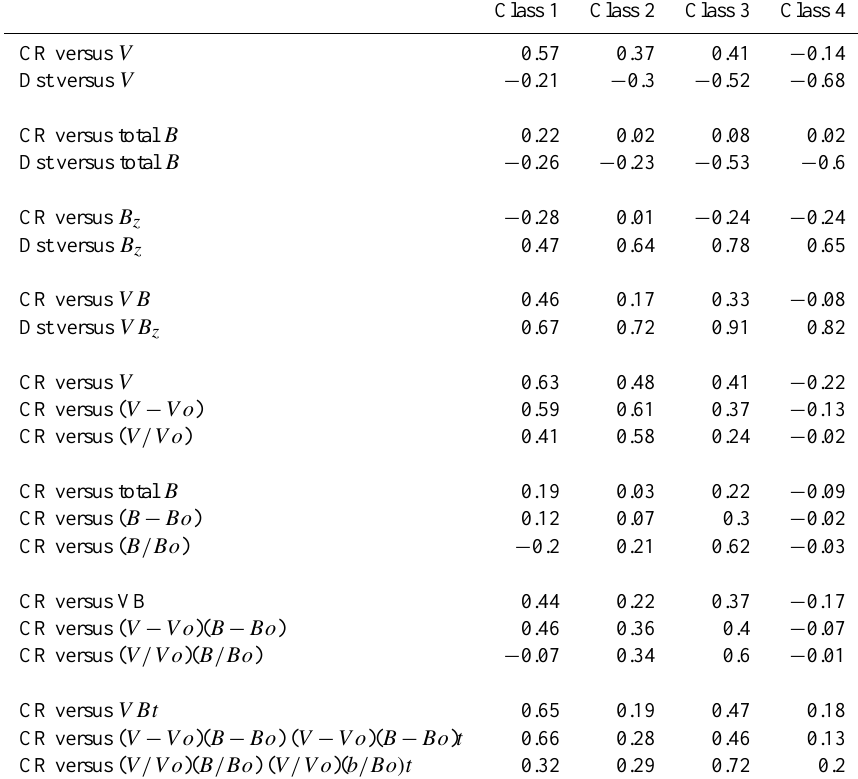
Table 1. Correlations of CR decreases and Dst depressions with interplanetary V , magnetic field components B , B z , and various combina- tions of the